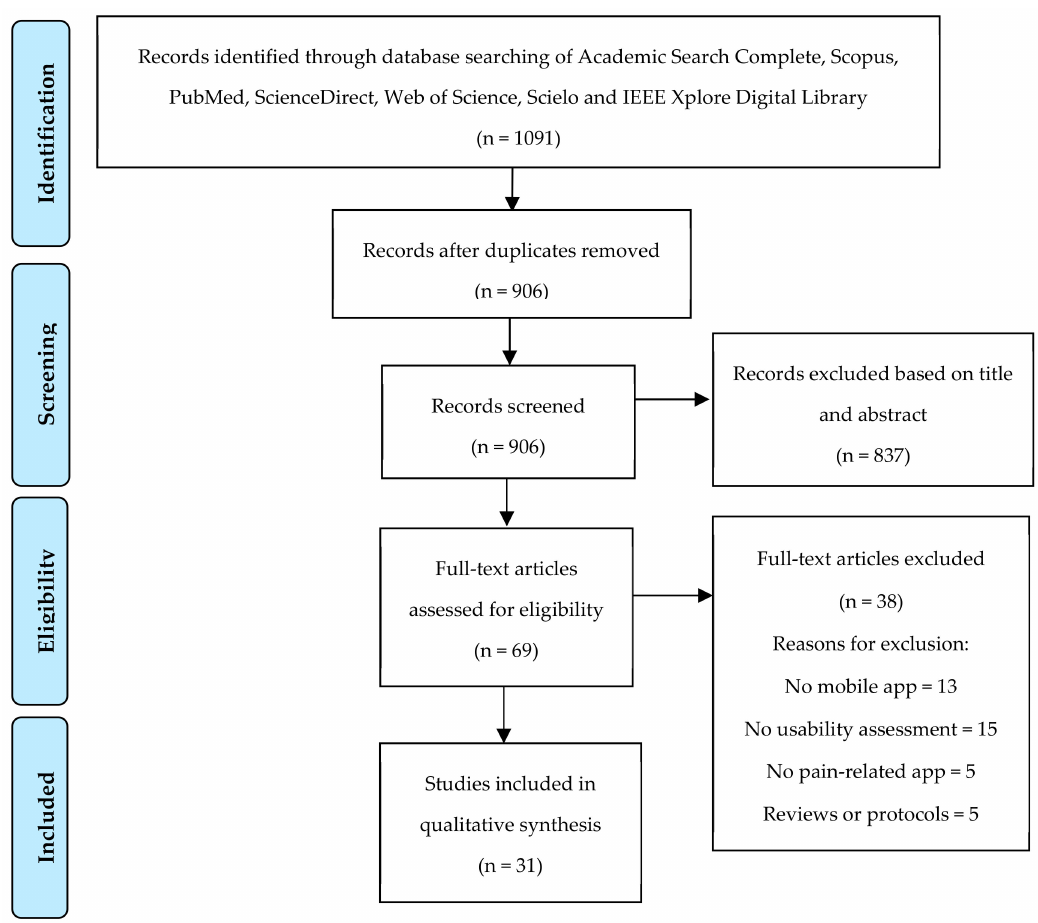
Figure 1. Study selection flowchart